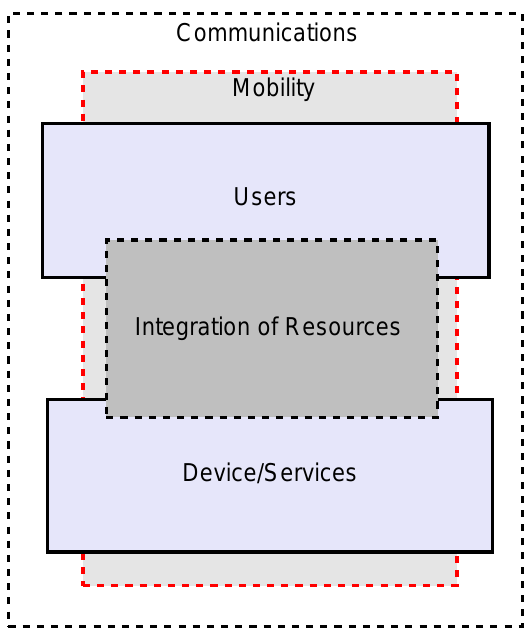
Figure 2. The devised threat and attack target categories. Table 2. An outline of the devised threats and attacks categories and their brief description.